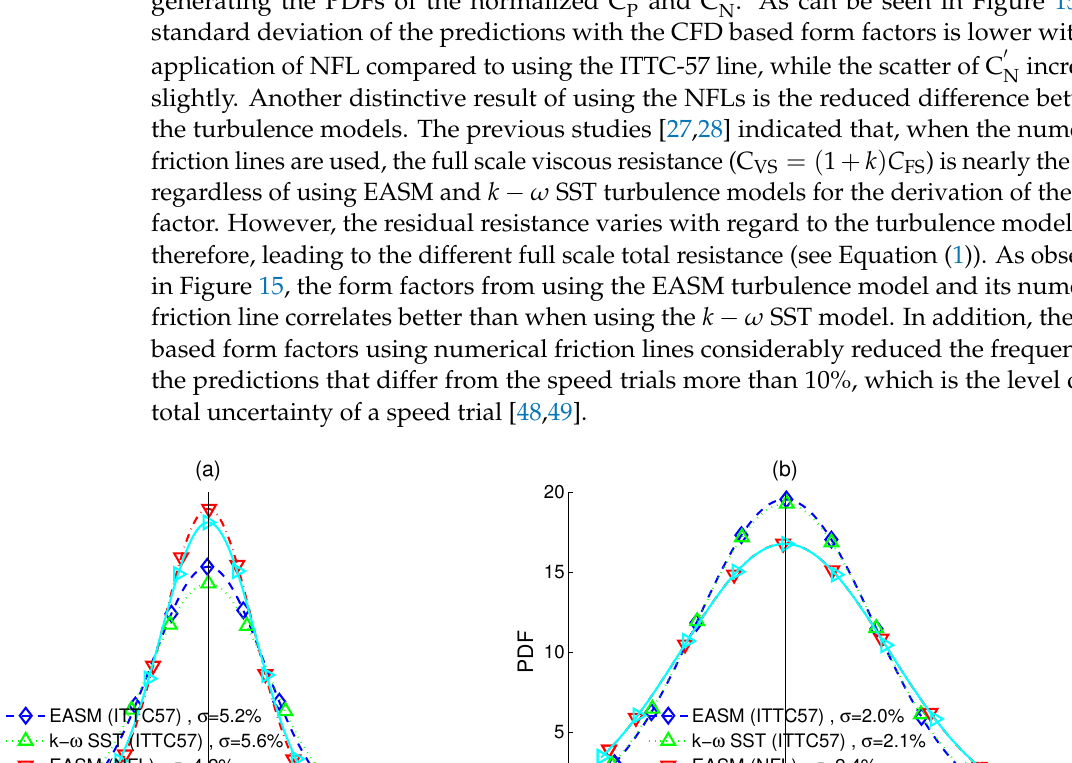
and ( b ) C (cid:48) P N